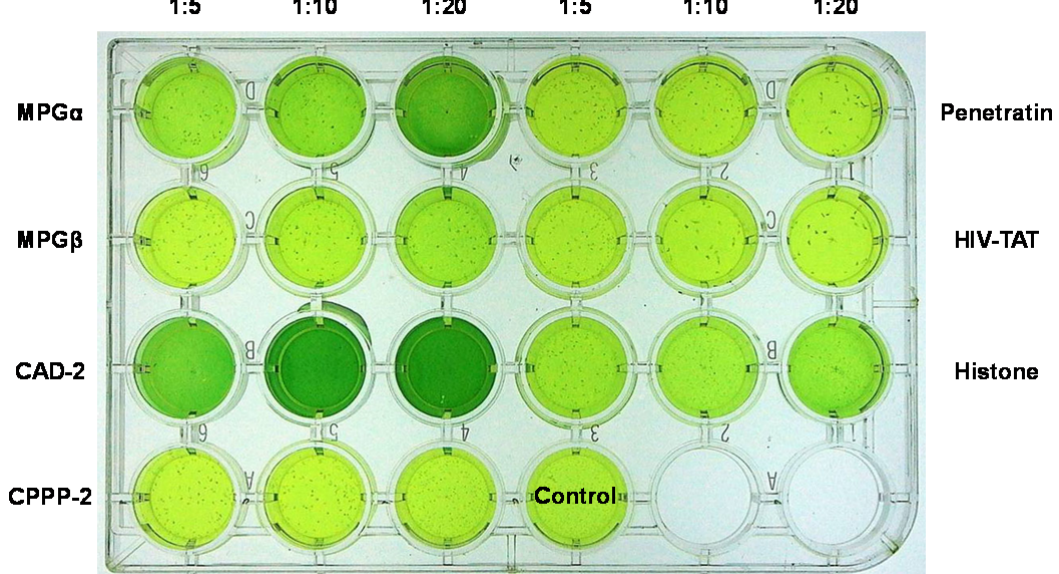
Figure 5. Internalization of β -galactosidase into Leishmania tarentolae . Complexes of β - galactosidase with CPPs as well as calf thymus histone formed in the indicated ratios were internalized into Leishmania . After staining with X-gal the intensity of the color in the current vial correlates with the intracellular amount of the active enzyme and thus with the transport efficiency of the respective CPP and